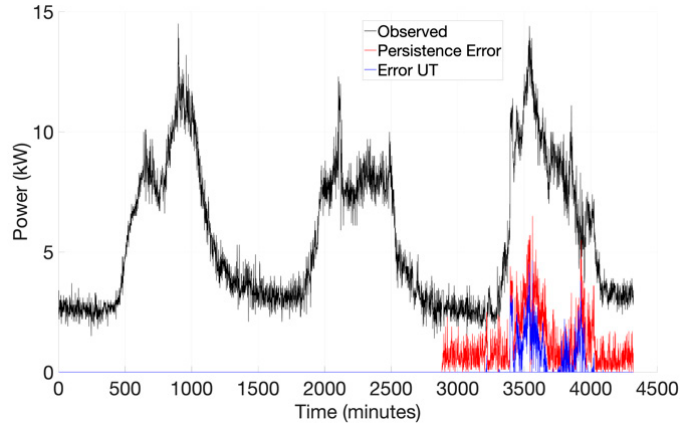
Figure 12. Persistence applied on demand forecasting plus error UT.